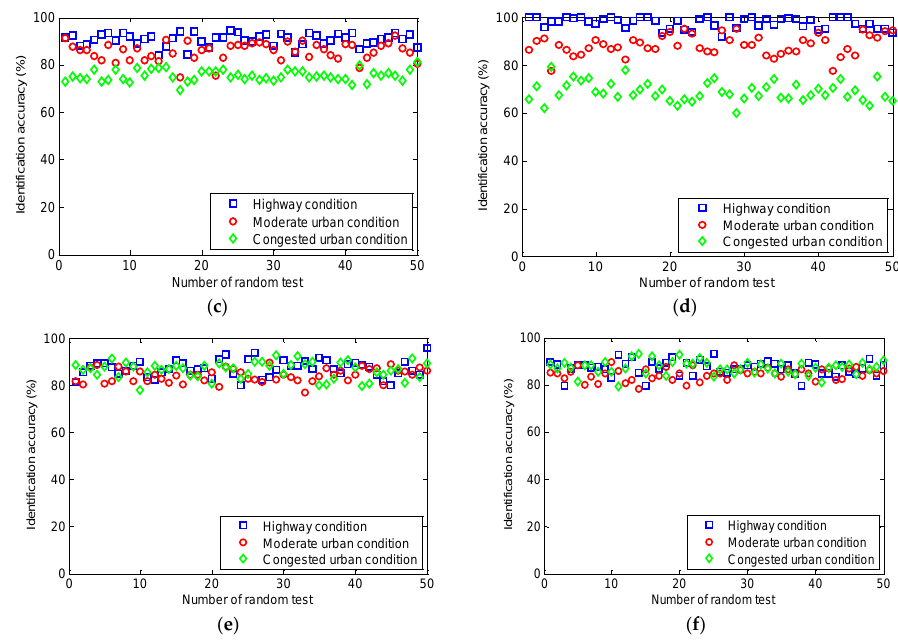
Figure 12. Identification accuracy of six groups of characteristic parameters. ( a ) First group of characteristic parameters; ( b ) Second group of characteristic parameters; ( c ) Third group of characteristic parameters; ( d ) Fourth group of characteristic parameters; ( e ) Fifth group of